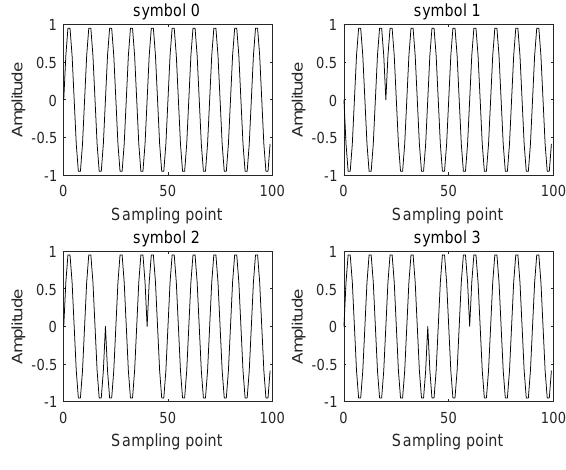
Figure 1. The MPPSK